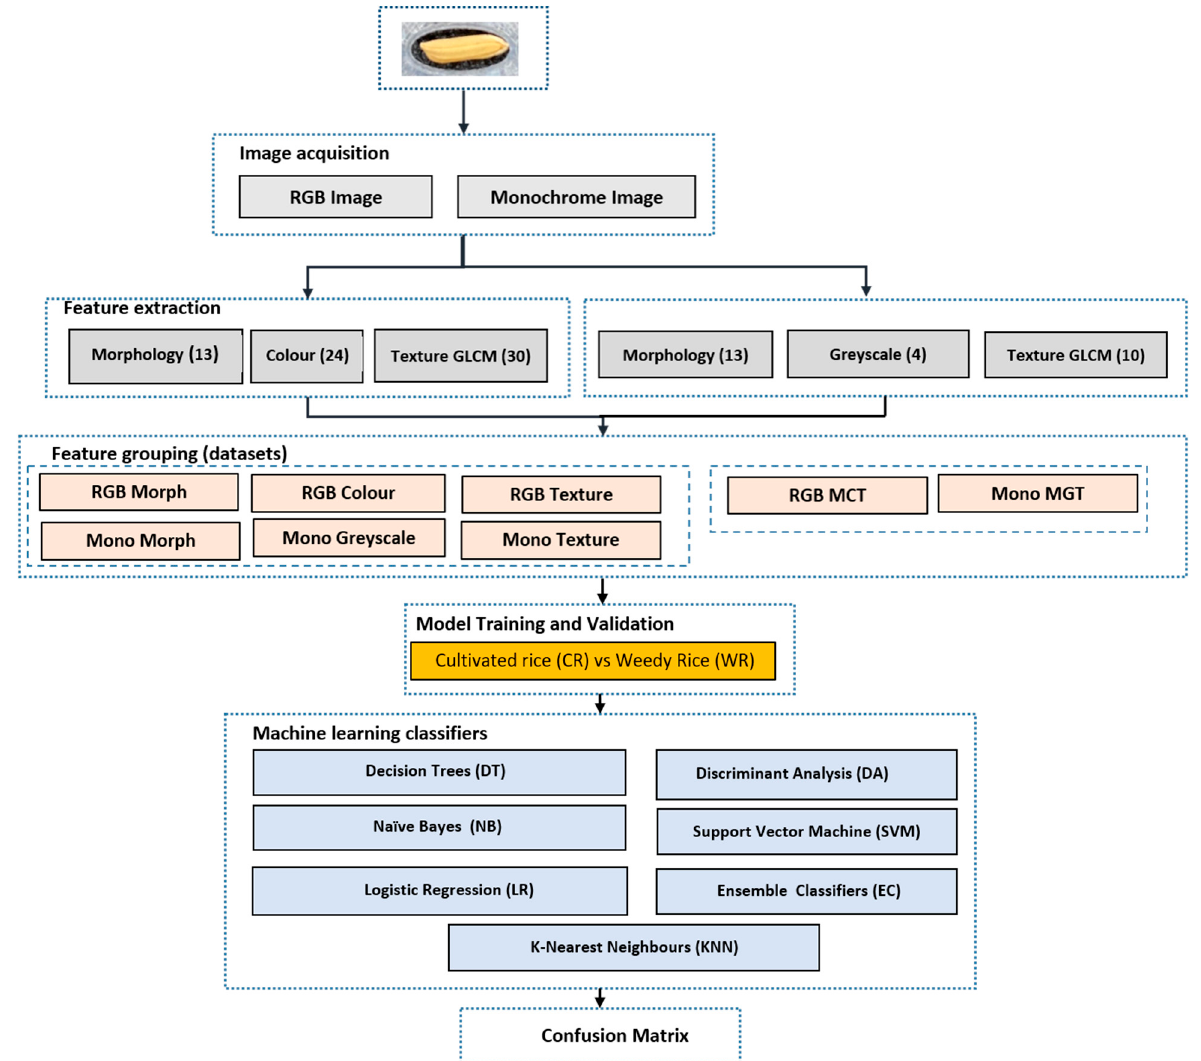
Figure 3. Summary of the analyses to classify the CR and WR conducted for this study.